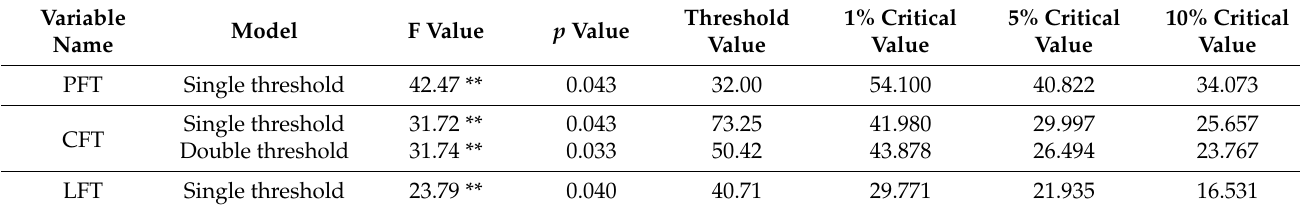
Table 7. Threshold effect test